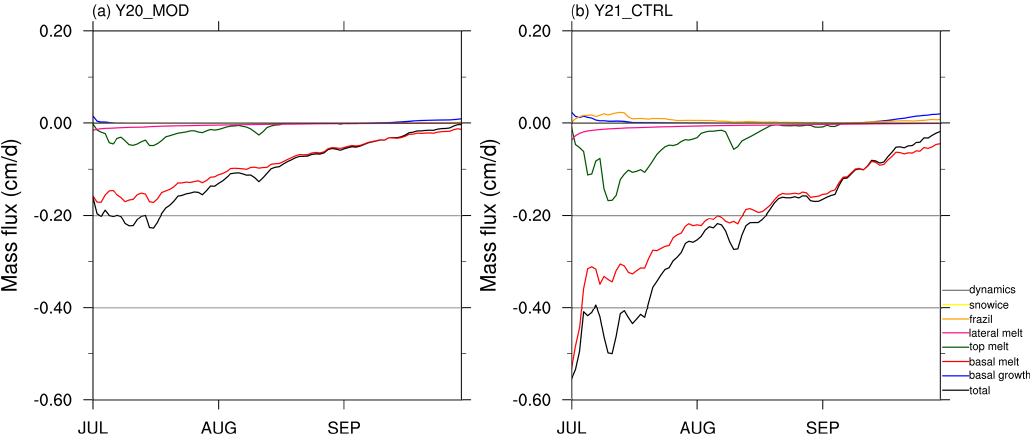
Figure 6. Time series of sea ice mass budget terms for (a) Y20_MOD (the original CAPS) and (b) Y21_CTRL (changes in the atmospheric physics).